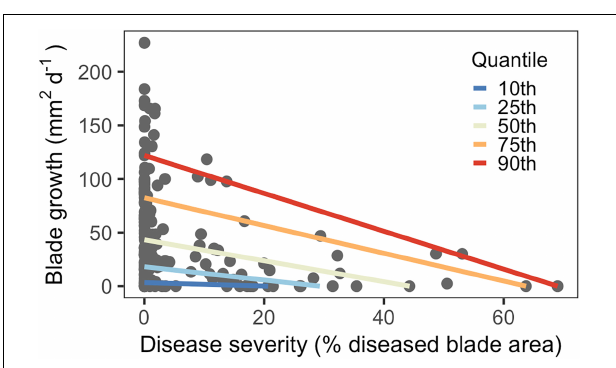
FIGURE 2 | Quantile regression model showing decreasing blade growth in response to disease severity for third-rank blades ( n = 176).